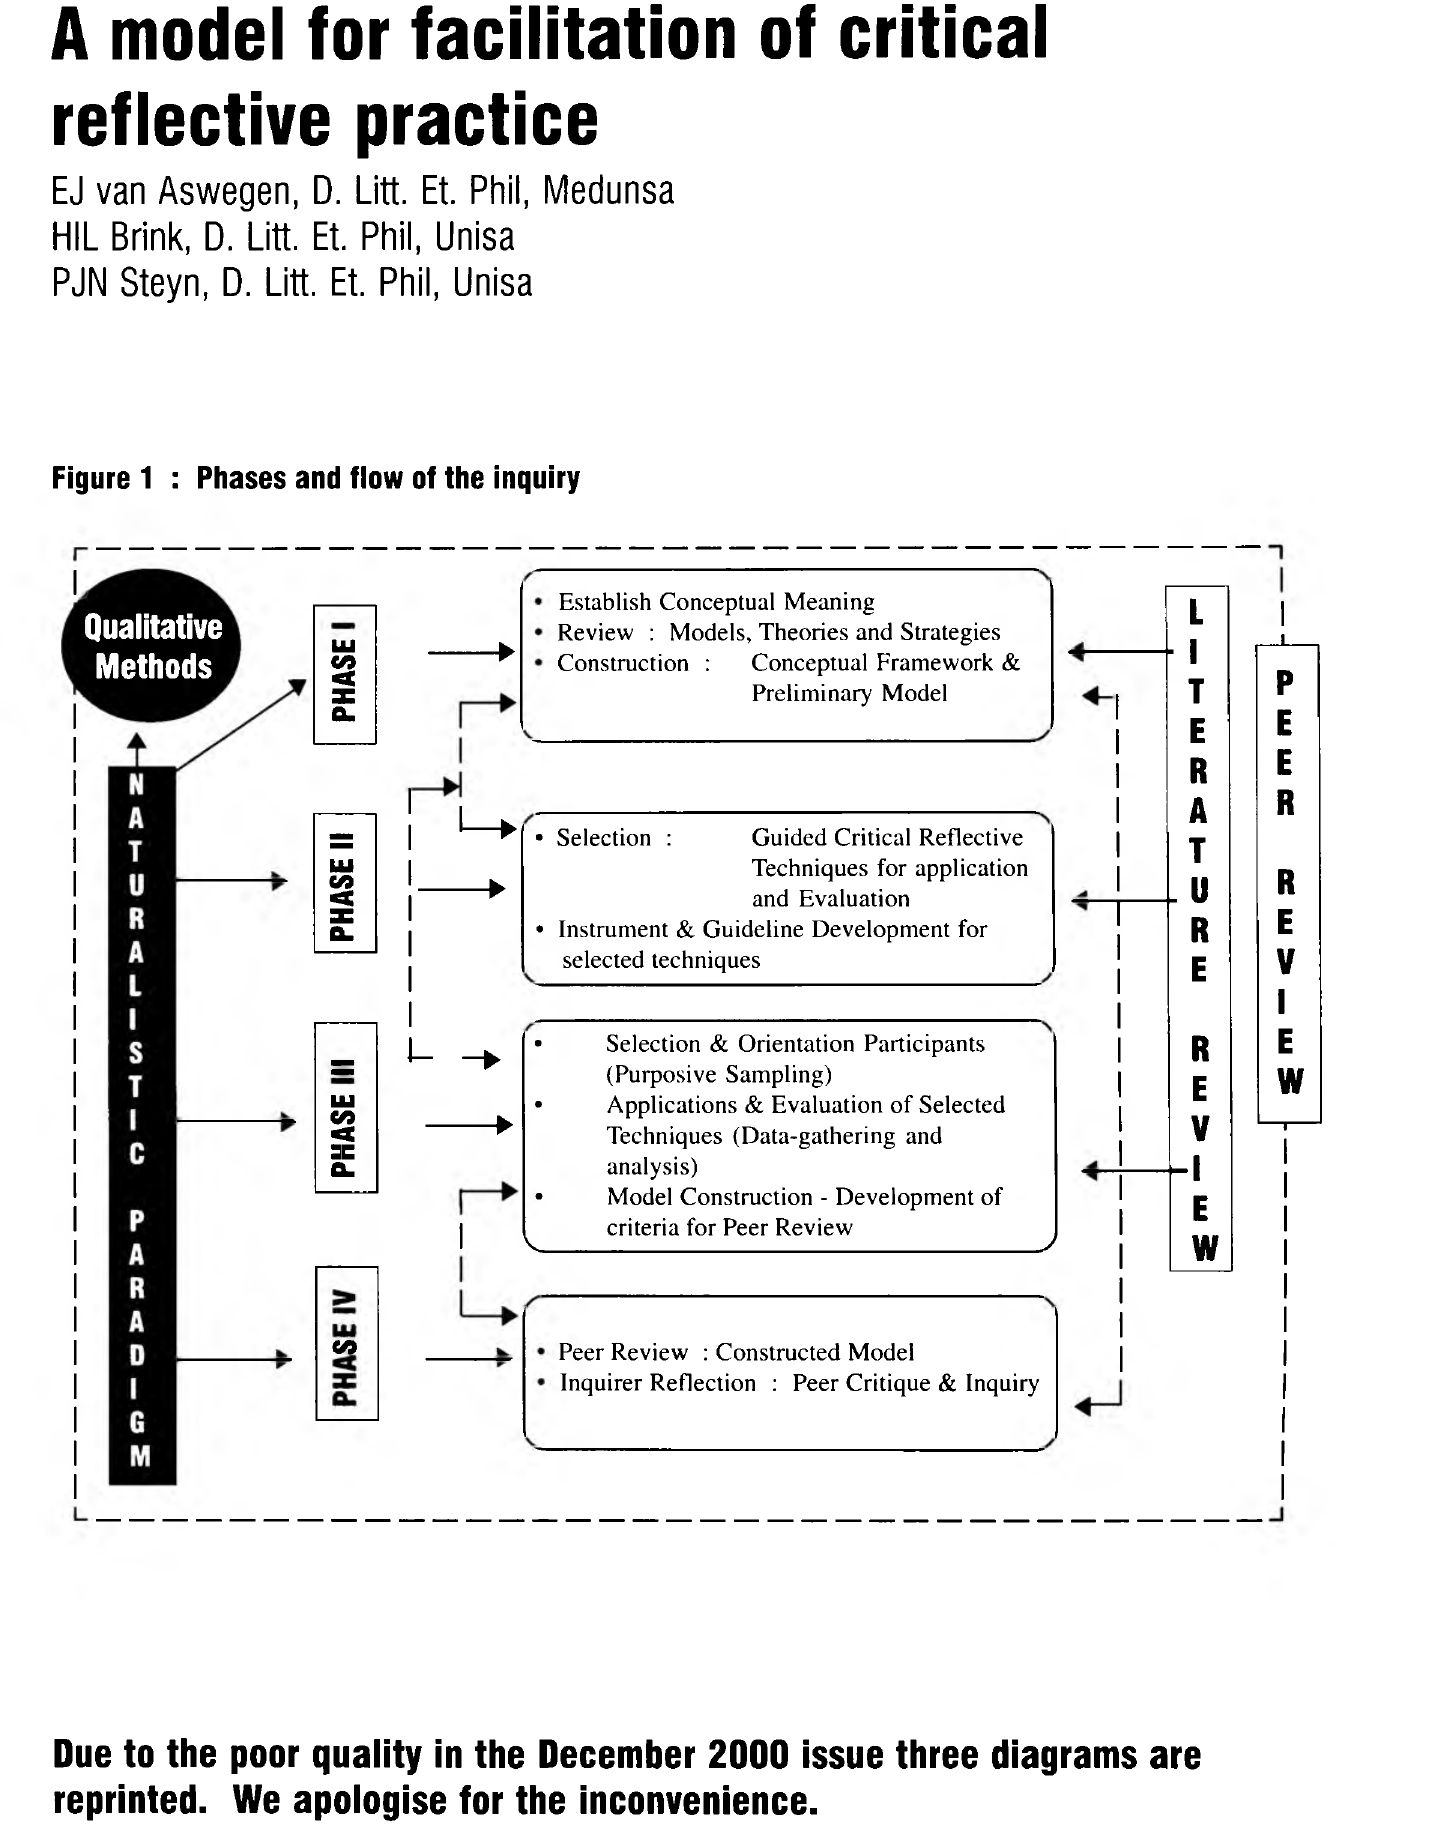
Figure 1 : Phases and flow of the inquiry